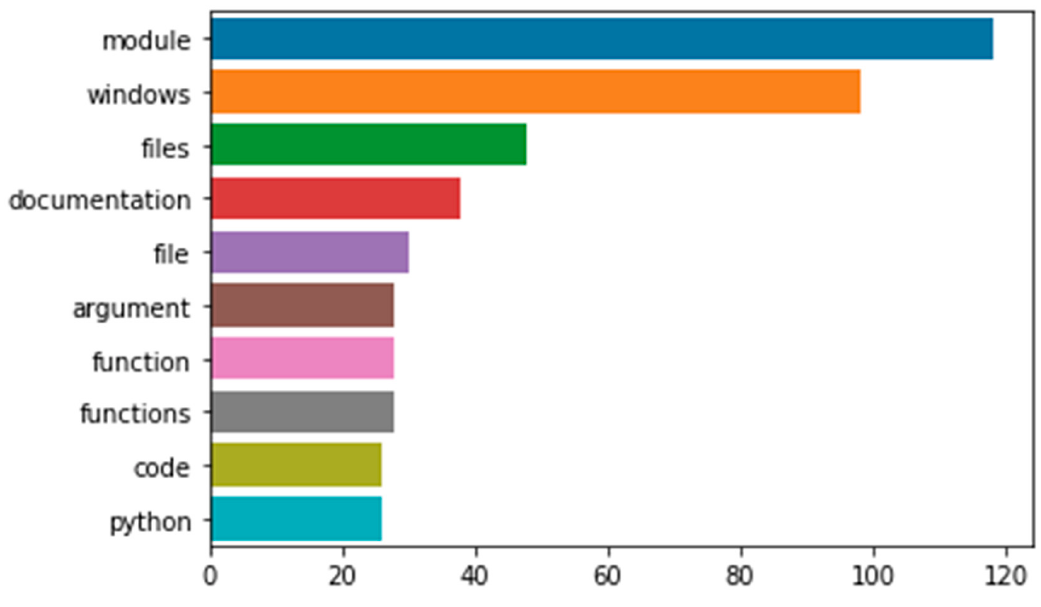
Figure 3. Most frequent unigrams of dataset.